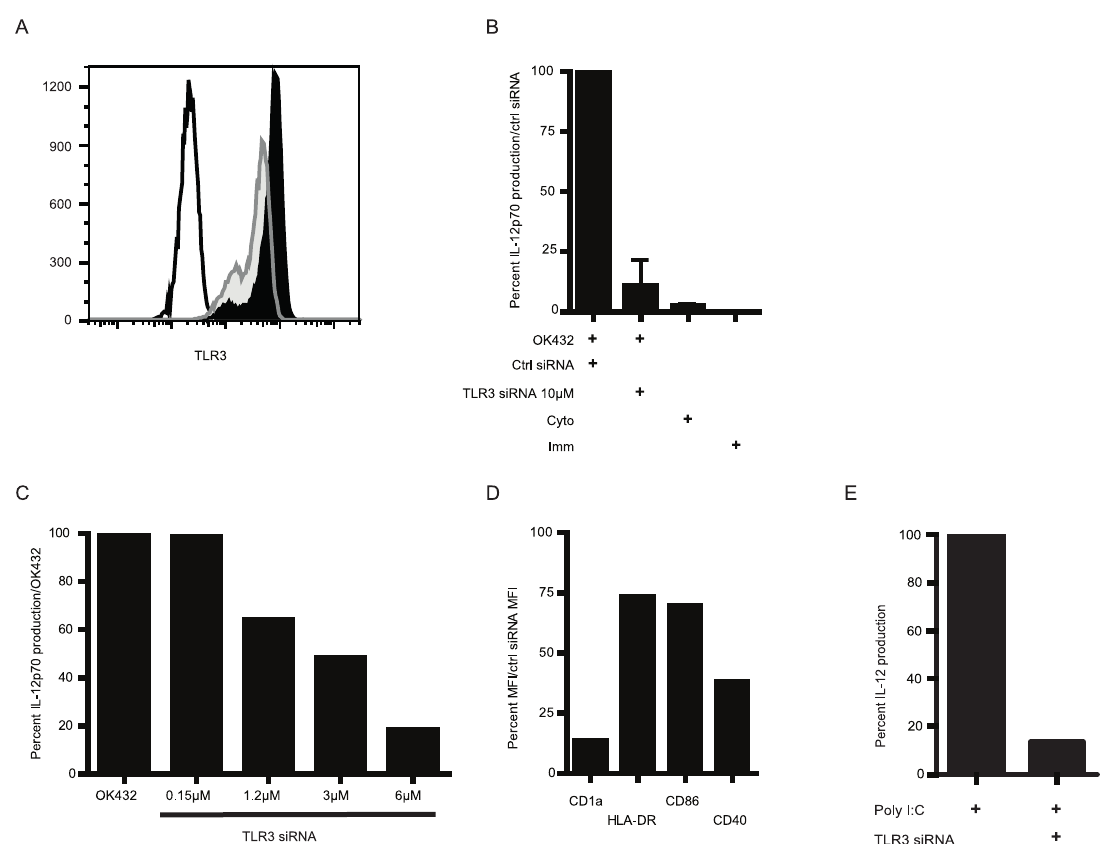
Figure 2. TLR3 knockdown has a considerable effect on OK432 induced IL-12p70 production by DC. A) DC were electroporated with either control siRNA that has no specific target in human cells or with two siRNA specific against TLR3. The level of siRNA mediated TLR3 knockdown was found to be around 40 percent after 24 hours of OK432 stimulation (48 h after electroporation). Open histogram: unstained control; shaded histogram: mock treated; black histogram: TLR3 siRNA treated; one representative experiment shown of five. B) After resting for 24 hours, the DC were incubated with OK432 for 24 hours and the supernatant was collected and analyzed for IL-12p70 production by ELISA. OK432 is critically dependent on TLR3 signaling to induce IL-12p70 production. Immature cells (Imm) received only IL-4 and GM-CSF, the Cyto group were matured with IL-1 b , IL-6, TNF- a and PGE 2 . Mean + SEM are shown for four donors. C) To further verify the specificity of the TLR3 siRNA knock down, DC were electroporated with escalating concentrations of TLR3 siRNA and rested for 24 hours. Subsequently, after 24 hour stimulation with OK432, IL-12p70 production was analyzed. One representative donor is shown out of three. D) TLR3 siRNA knockdown has a marked effect on the phenotype of OK432 matured DC. Percent MFI of CD1a, HLA-DR, CD86 and CD40 after TLR3 siRNA knock down and OK432 stimulation compared to OK432 plus control siRNA (set to 100%). Mean of two donors shown. E) TLR3 siRNA inhibit IL-12p70 production upon polyI:C stimulation of DC. IL-12p70 production of polyI:C treated DC were set to 100%. One representative donor is